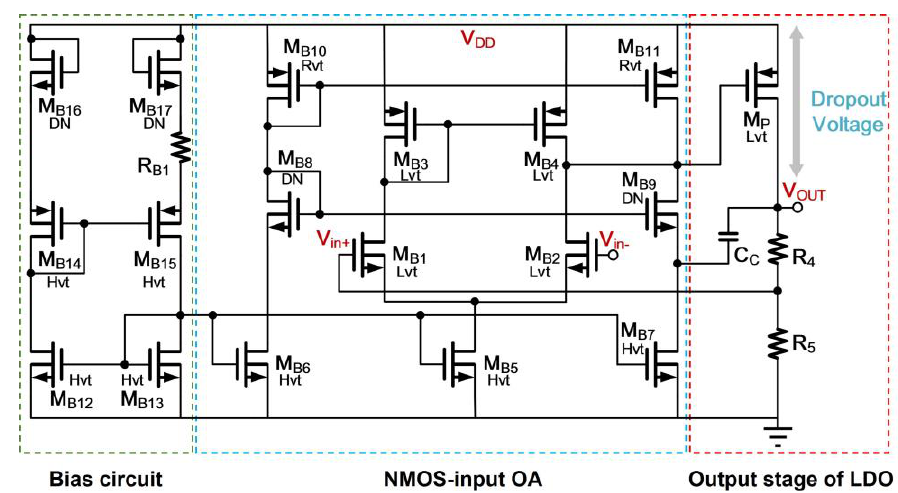
Figure 5. Schematic of OA 2 for Regulator in Enhancer. Table 1. Sizes of the Devices in the Conventional Design.